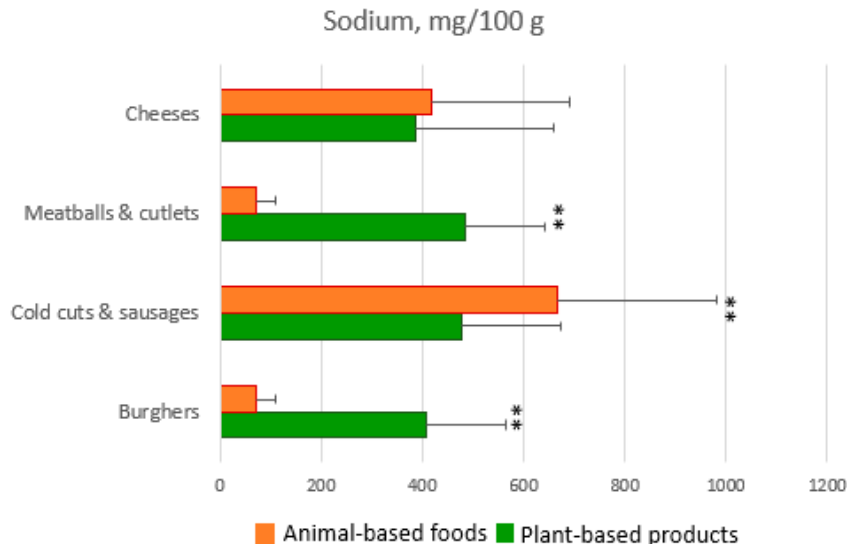
Figure 4. Sodium content of processed plant-based products vs. regular animal-based products. ** p < 0.01. All the data were presented as mean ± SD.